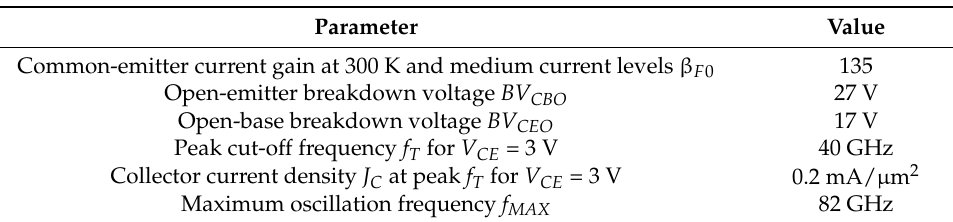
Table 1. Key features of the investigated HBT technology.